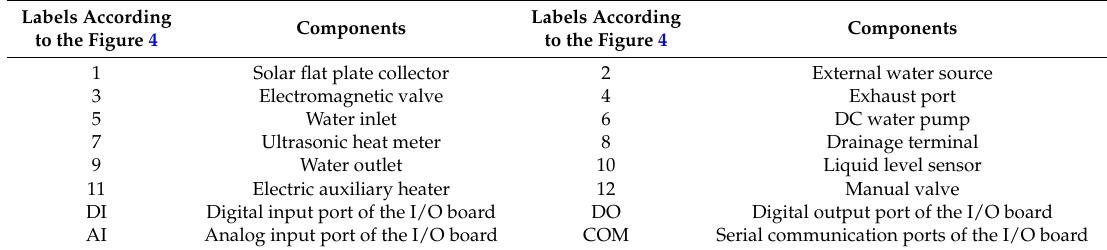
Table 3. The components according to the Figure 4.